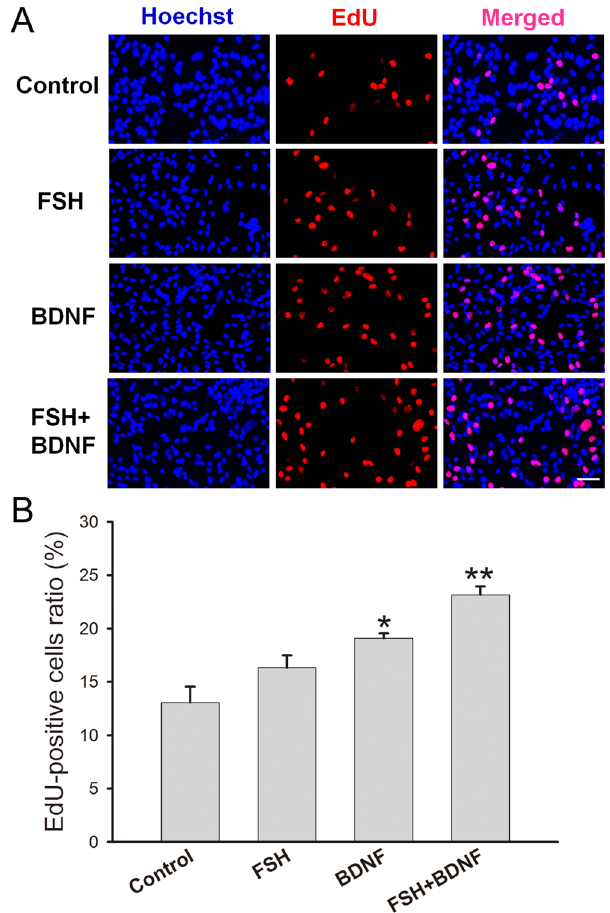
Figure 3. Effect of BDNF on cell proliferation. KGN cells were treated with FSH (100 ng/ml), BDNF (5 ng/ml) and FSH (100 ng/ml) plus BDNF (5 ng/ml), respectively, for 24 h, and cell proliferation was detected by EdU assay. ( A ) Red fluorescence represents EdU-positive cells and blue fluorescence shows cell nuclei. ( B ) Relative ratio of EdU-positive cells of treated and untreated groups. * P < 0.05 and ** P < 0.01 versus control group. Scale bar = 50 μ